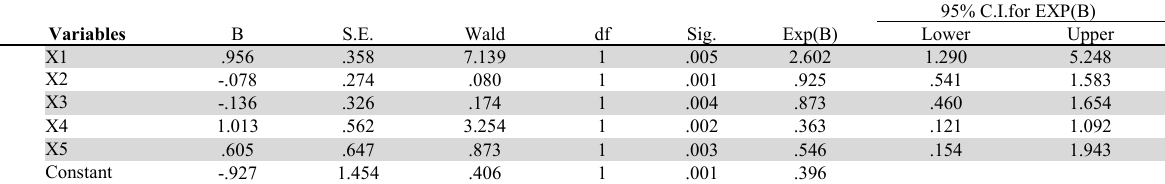
Results for the binary logistic regression model Variables